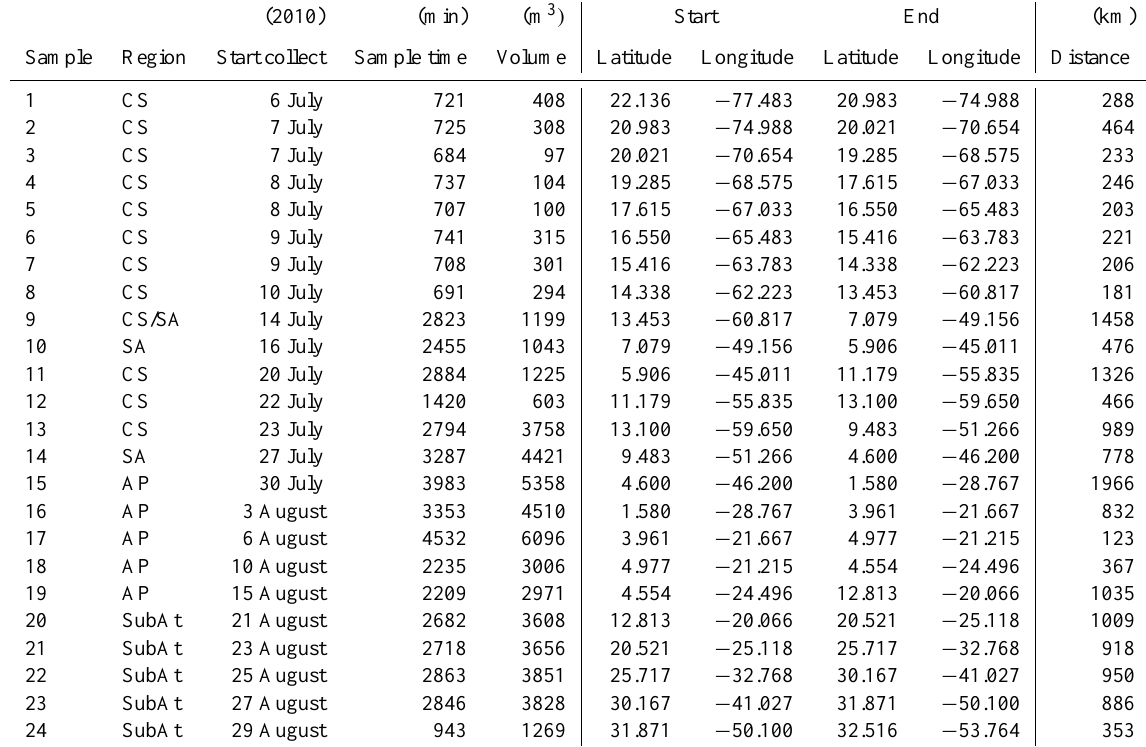
Table 1. Sampling dates, volumes, coordinates, and total distance for each samples collected. Regional abbreviations as CS (Caribbean Sea), SA (South America), AP (African plume), and SubAt (subtropical Atlantic) were